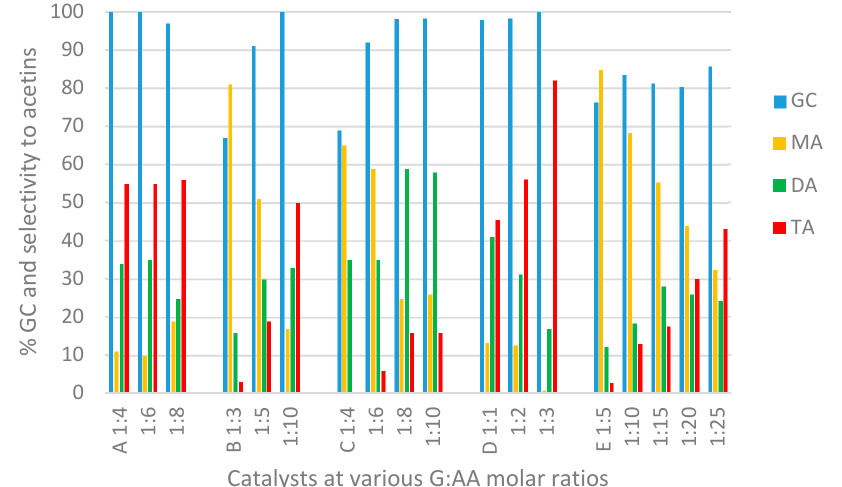
Figure 12. Influence of glycerol to acetylating agent (G:AA) molar ratios on glycerol conversion (GC) and selectivity to monoacetin (MA), diacetin (DA) and triacetin (TA) using different catalysts at various reaction conditions (A = 3% Y/SBA, AAc = acetic acid, T = 100 °C, CL = 0.2 g, t = 3 h [82]; B = 20 mol%MnO 3 /SiO 2 , AAc, T = 100 °C, CL = 10 wt%G, t = 8 h [132]; C = CsPWA, AAc, T = 85 °C, CL = 7 wt%Gly, t = 2 h [89]; D = CsPWA, AAh = acetic anhydride, T = 30 °C, CL = 4 wt%G, t = 2 h [89]; E = 1Ag-10 Cu-rice husk silica–Al 2 O 3 , AAc, T = 110 °C, CL = 80 mg, t = 5 h [90].